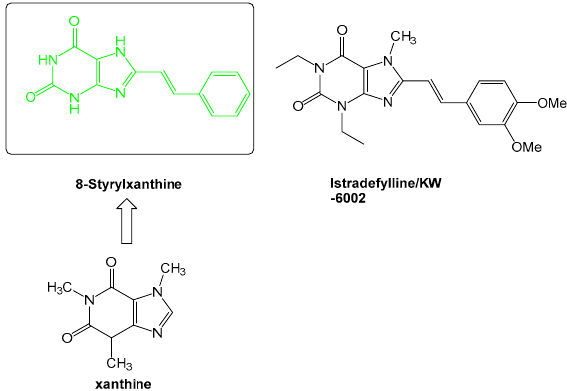
Figure 5. The progression from xanthines, such as caffeine, to the novel compound istradefylline, which was recently approved for the use in Parkinson’s diseases.